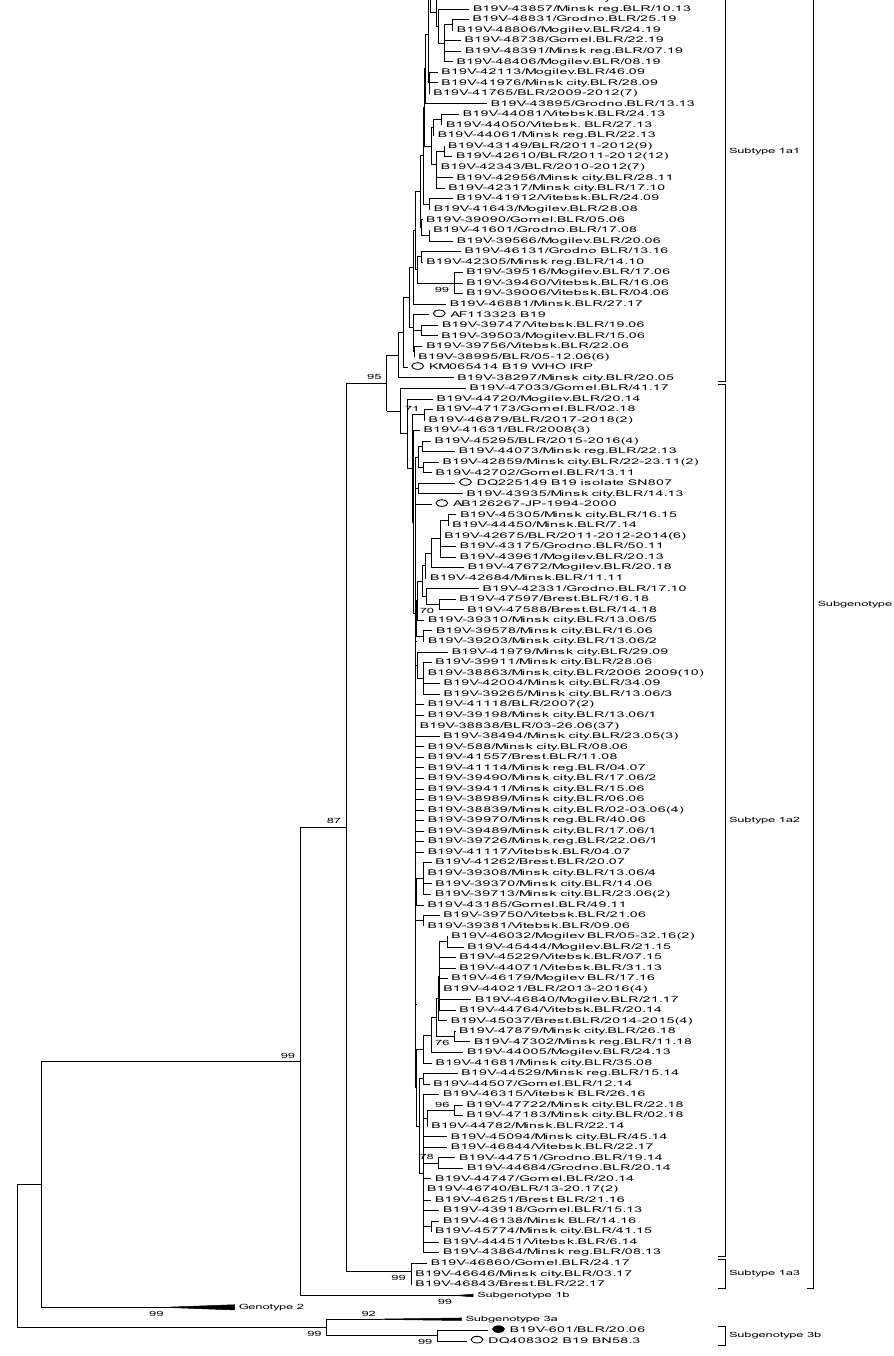
Figure 5. Phylogenetic tree based on 994 nt of the NS1/VP1-unique region junction including the B19V sequences from Belarus. Only one representative strain is shown for identical sequences of subtypes 1a1 and 1a2, and the total number of sequences is added behind in brackets; all three sequences of the provisional subtype 1a3 are presented; the subgenotype 3b strain is marked with a black dot. The strains are named with location, epidemiological week and year or with country name and year/years for representative strains of identical sequences isolated at different time points and/or at different locations. The reference sequences are identified by GenBank accession number and name and are marked with an open circle. Only bootstrap values ≥ 70% (1000 replicates) are